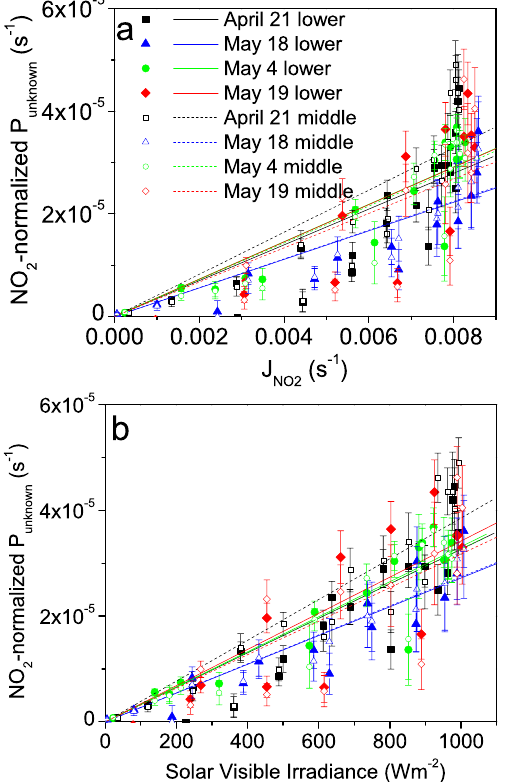
Fig. 8. Correlations of the NO 2 -normalized P unknown with J NO (a) and solar irradiance (b) in the lower and middle height 2 intervals on four sunny days (21 April, 4 May, 18 and 19 May) dur- ing SHARP 2009. Results of the linear fits are shown in Table